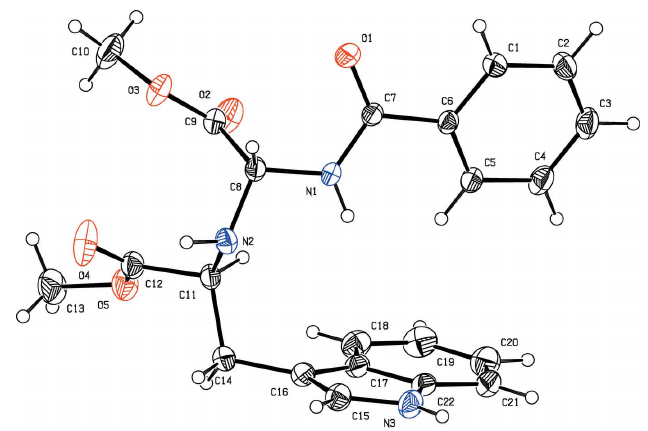
Figure 1 The structure of the title compound, showing the atom-labelling scheme. Displacement ellipsoids are drawn at the 50% probability level. H atoms are represented as small spheres of arbitrary